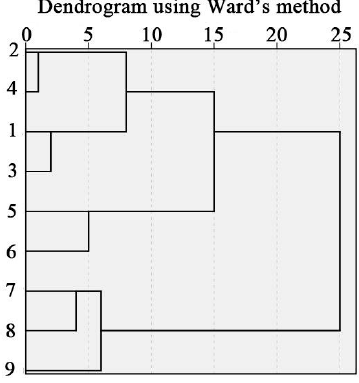
Figure 7: Correlation dendrogram for fiber bundle tensile test